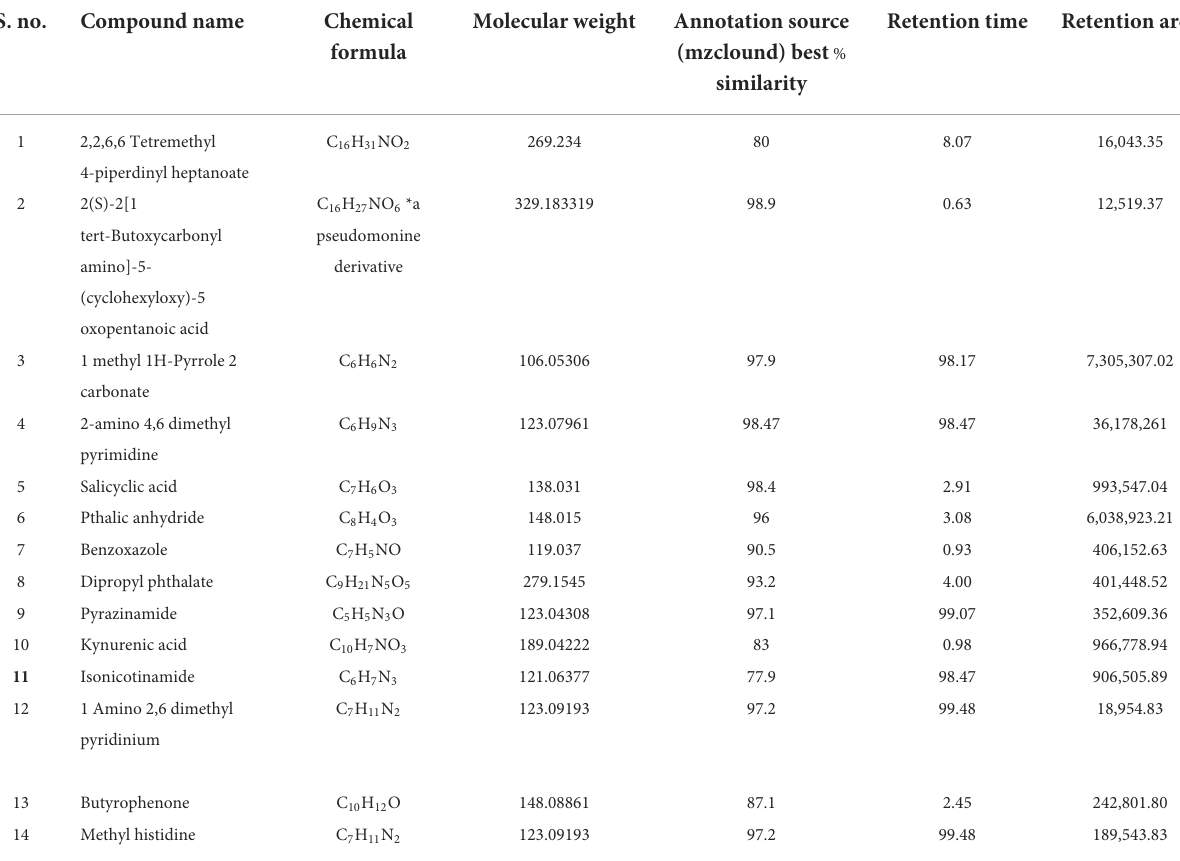
TABLE 1 Compounds detected in LC-MS in strain Pseudomonas monteillii . S.